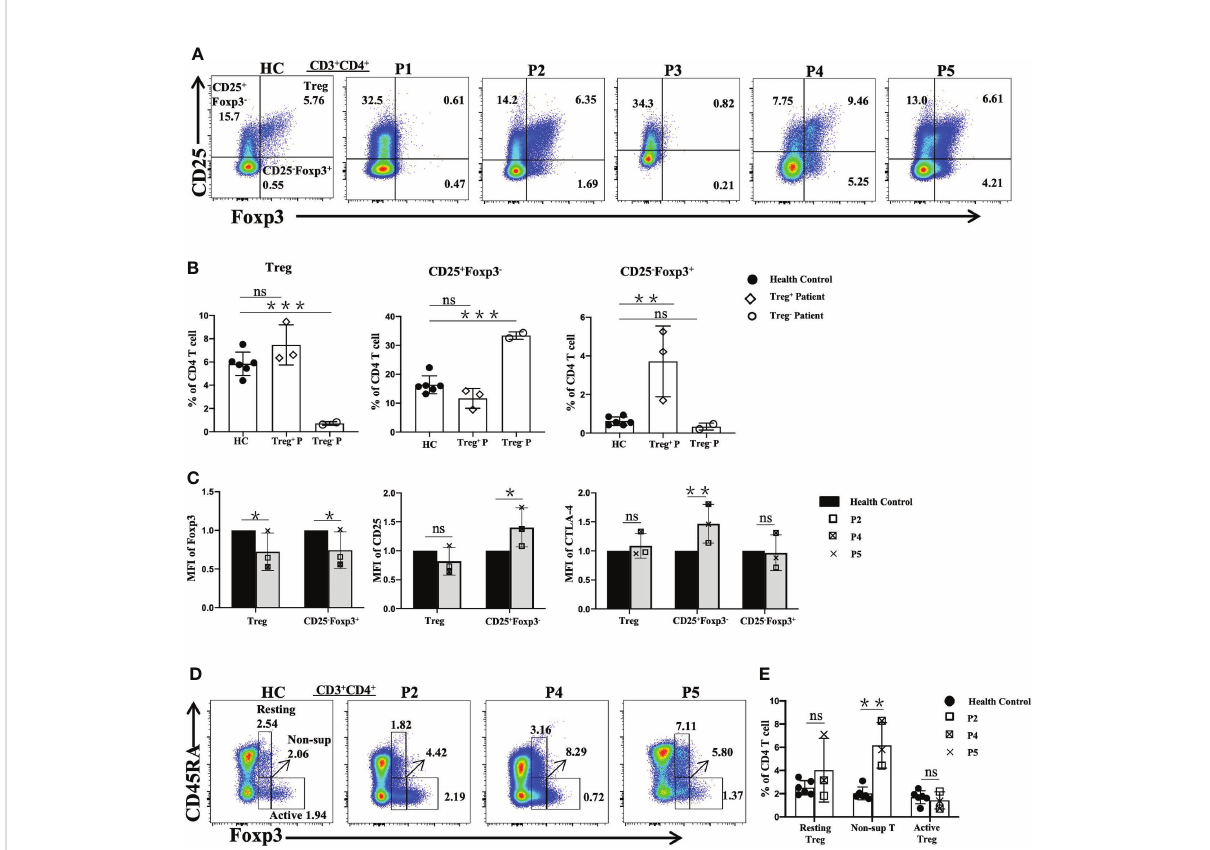
FIGURE 3 Flow cytometric analysis of Treg-cell subsets in patients with FOXP3 mutations. (A) and (B) The percentages of Treg (CD4 + CD25 + Foxp3 + ), CD25 + Foxp3 - CD4 + T and CD25 + Foxp3 - CD4 + T cells among CD4 + T cells. (C) The mean fl uorescence index of Foxp3, CD25 and CTLA-4 in different cells. (D) and (E) The percentages of Treg-cell subsets, namely, resting Treg (CD45RA + Foxp3 + ), non-suppressive T (CD45RA - Foxp3 + ) and active Treg (CD45RA - Foxp3 ++ ) cells among CD4 + T cells. Treg + Patient, patient with normal numbers of Treg cells; Treg - Patient, patient without Treg cells. *P<0.05; **P<0.01; ***P<0.001; ns, no signi fi